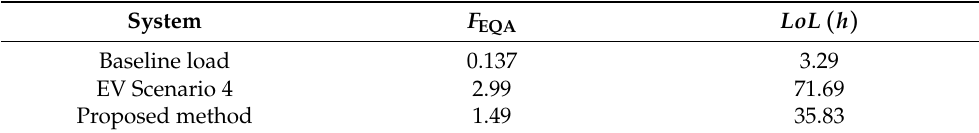
Figure 15. Transformer life indices in scenario 4, ( a ) hottest-spot temperature, θ H ; ( b ) accelerated aging factor, F AA . Table 8. F EQA and LoL in scenario